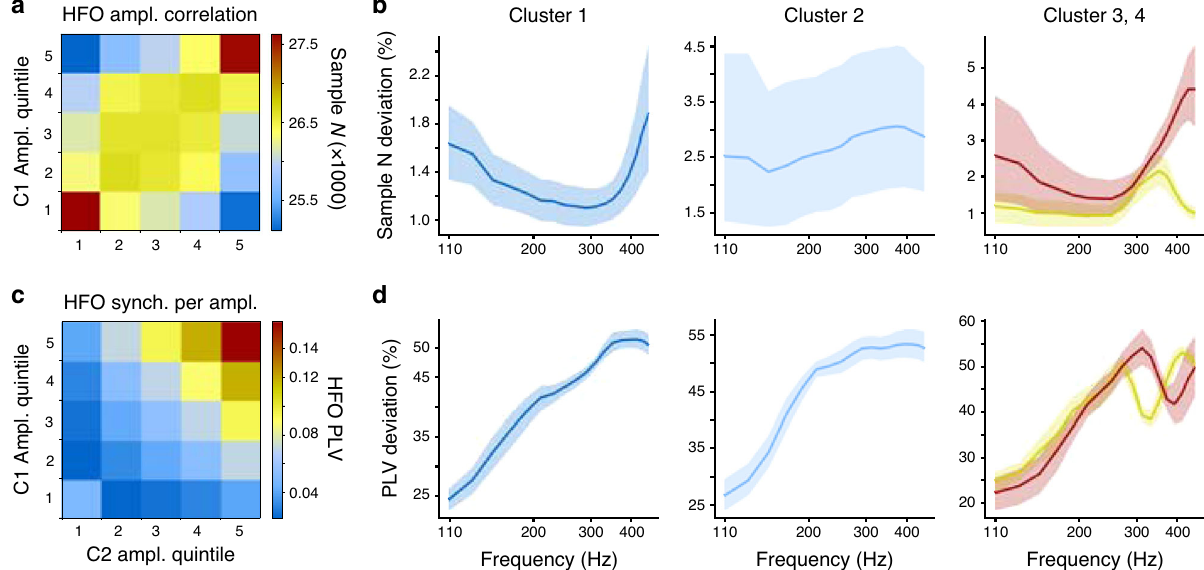
Fig. 6 HFO synchrony is the strongest during moments of high-amplitude HFO. a Histogram of the HFO amplitude coincidences for all pairs of contacts (C1 and C2), showing a saddle with peaks when both amplitudes are either at their highest or lowest values. b Absolute mean deviation (%) of numbers of samples in a from uniform distribution as a function of high-gamma frequency. Shaded areas indicate bootstrap con fi dence intervals for the mean (5 and 95%-tile, N bootstraps = 1000)). c Moment-to-moment HFO synchronization (PLV) for SEEG electrode contact pairs (C1, C2) is dependent on the HFO amplitude at both contacts. Each matrix element is the mean of instantaneous PLV between all signi fi cant contact pairs as a function of their moment-to- moment normalized amplitudes. d Mean absolute deviation (%) of the observed PLV in bins of contact amplitudes (see c ) from uniform distribution as a function of high-gamma frequency. Shaded areas indicate bootstrap con fi dence intervals for the mean (5 and 95%-tile, N bootstraps =